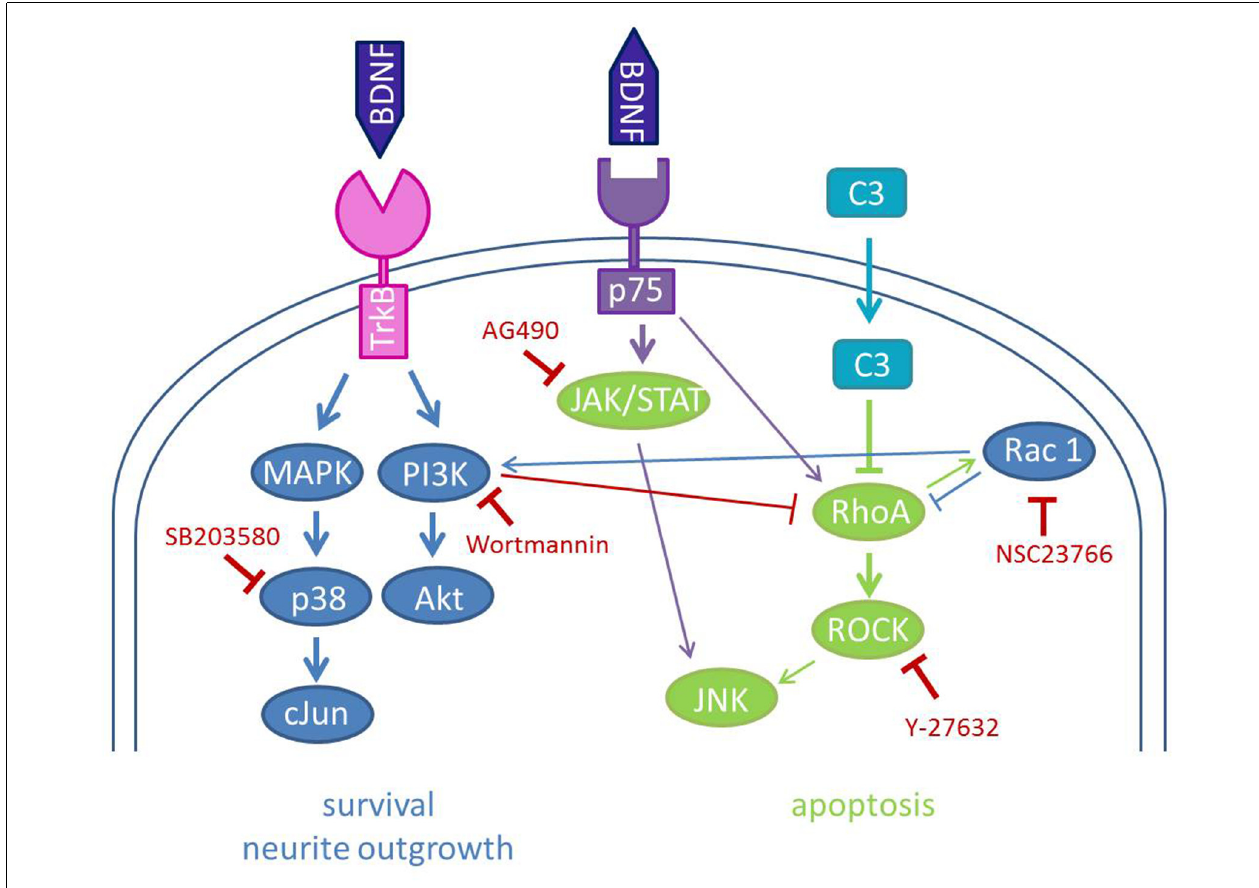
FIGURE 6 | Schematic illustration of the used inhibitors and the signal transduction pathways involved in BDNF and C3 effects on SGN. The neurotrophin brain-derived neurotrophic factor (BDNF) binds to its high-affinity receptor TrkB and its low-affinity receptor p75NTR. The main interactions of BDNF are depicted in blue and mediate neurite outgrowth and survival. Binding to p75NTR leads to the activation of the JAK/STAT pathway and also of RhoA inducing apoptosis and growth inhibition. C3 inhibits the activity of RhoA which results in the inactivation of the ROCK signaling pathway and diminishes growth inhibition. Rac1 activates the PI3K to activate Akt and thereby enhances neuronal survival. The used inhibitors of this study are depicted in red. Inhibition of Rac1 by NSC23766 and p38 by SB203580 leads to no outgrown neurites in SGN. Wortmannin (inhibition of PI3K) seems also to reduce the survival rate of SGN after combined treatment with C3 and